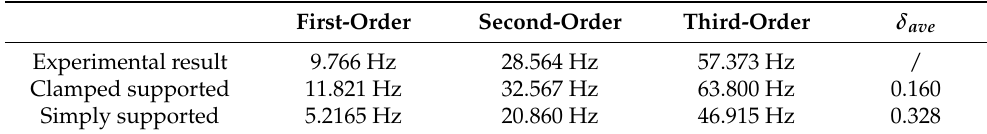
Table 2. The first three natural frequencies of the tube.